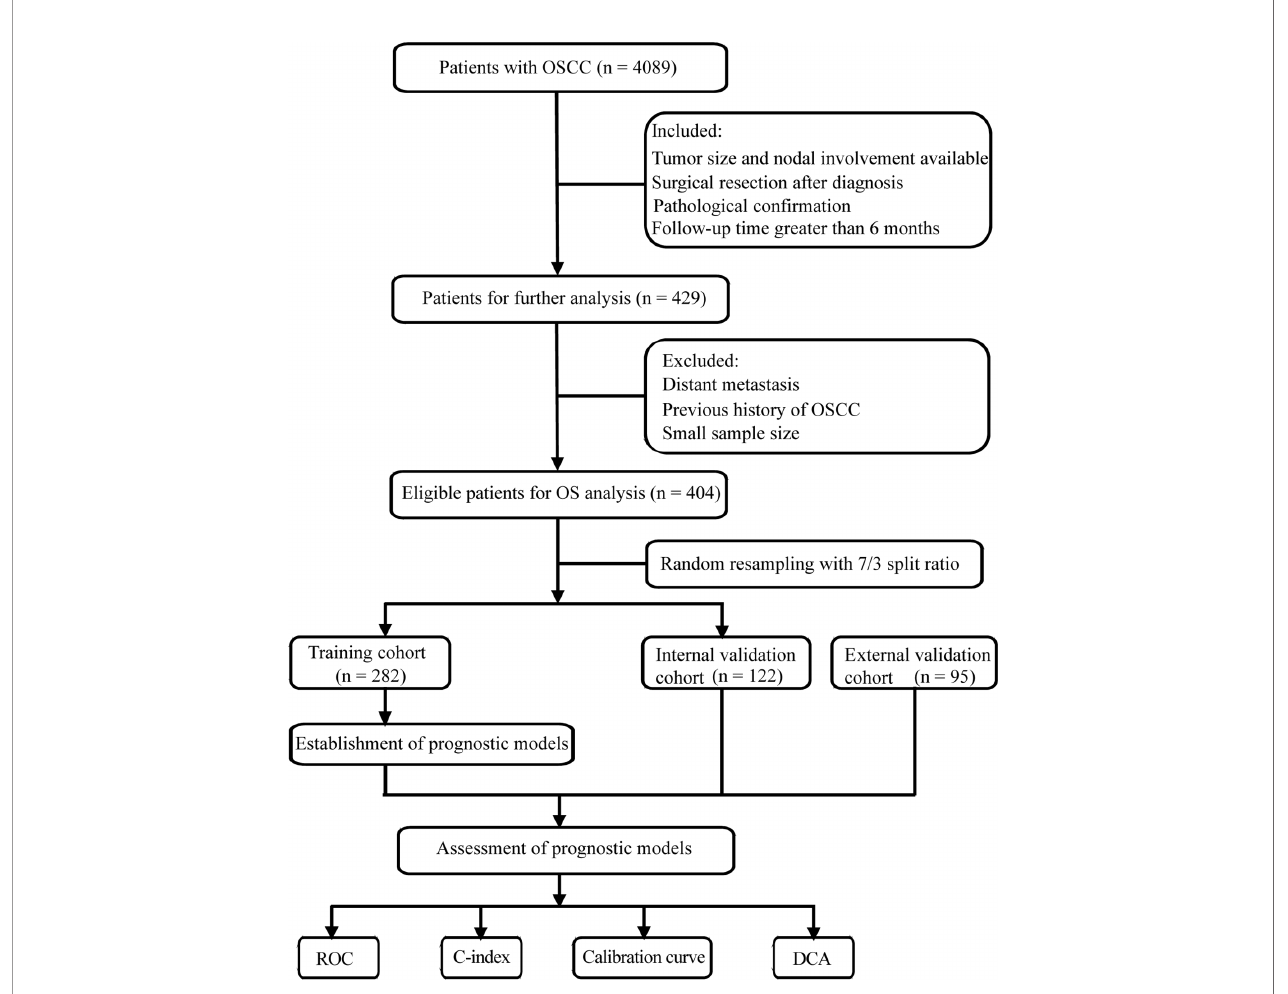
FIGURE 1 | Flow chart of screening process and experimental procedure. OSCC, oral squamous cell carcinoma; ROC, receiver operating characteristic curve; C-index, concordance index; DCA, decision curve